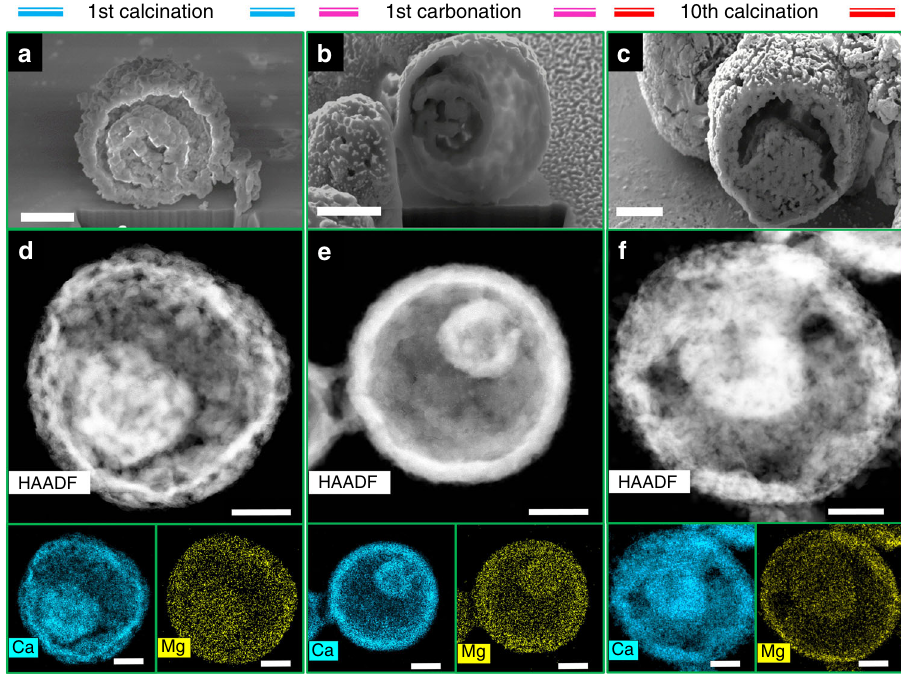
Fig. 5 Morphological changes during cyclic operation. a – c SEM images of FIB cross-sections. d – f HAADF-STEM images with EDX maps of Ca and Mg for Ca85Mg15 at different stages of CO 2 capture/regeneration cycles. Scale bars: 1 μ m for a – c and 700 nm for d – f ,